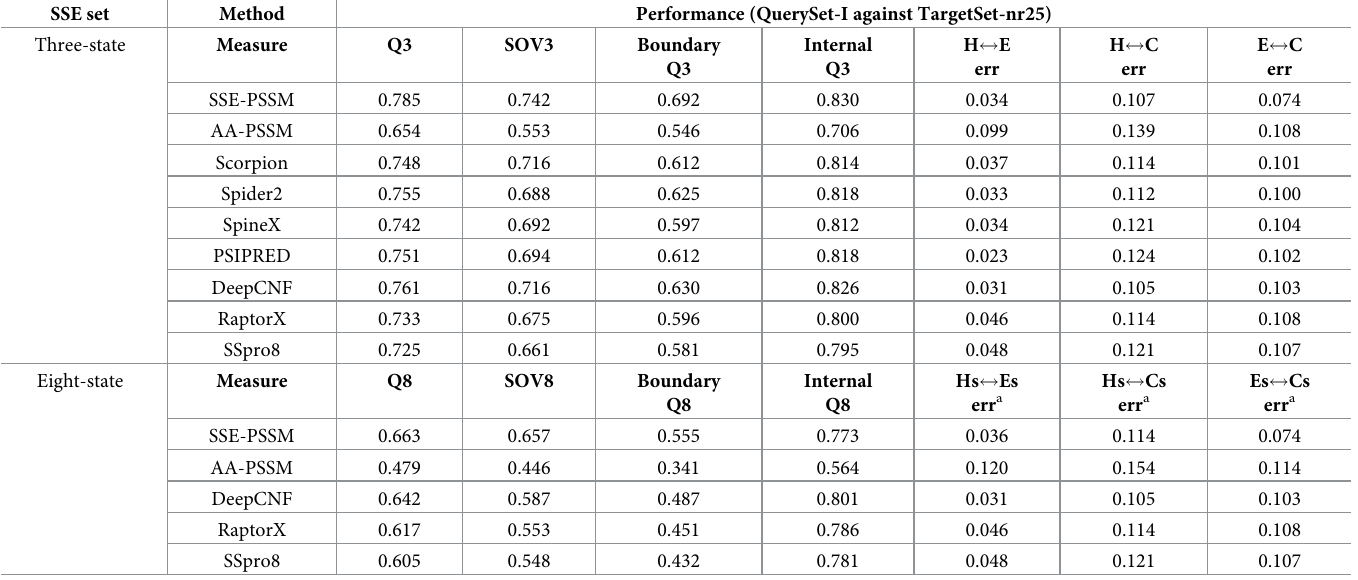
Table 1. Accuracy of the SSE-PSSM and several state-of-the-art SSP methods. SSE